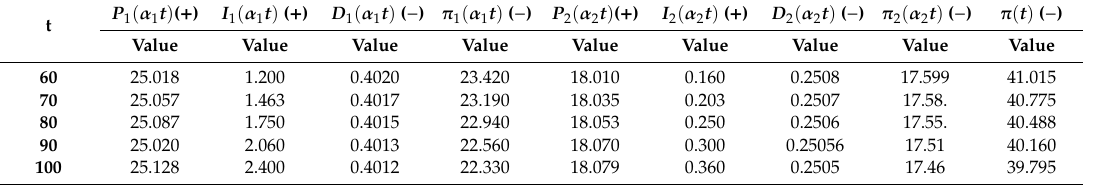
Table 4. Sensitivity analysis of α 1 : α 2 = 50%:50%. Unit: million NT$.